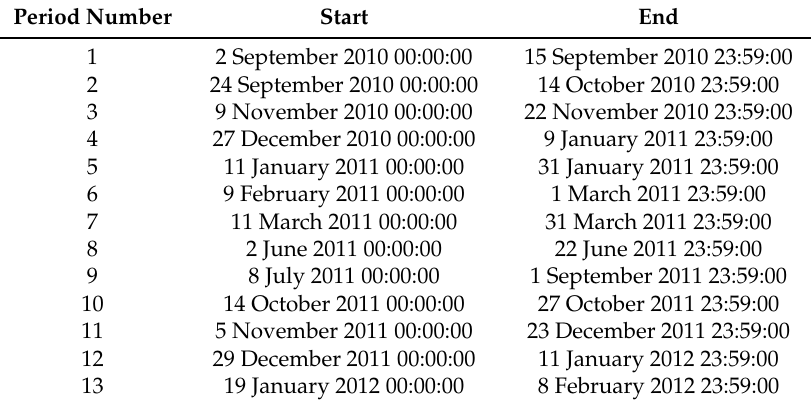
Table 4. The periods selected in the first stage.